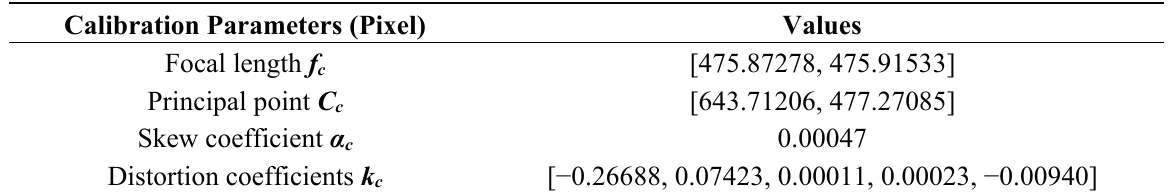
Table 1. The calibration